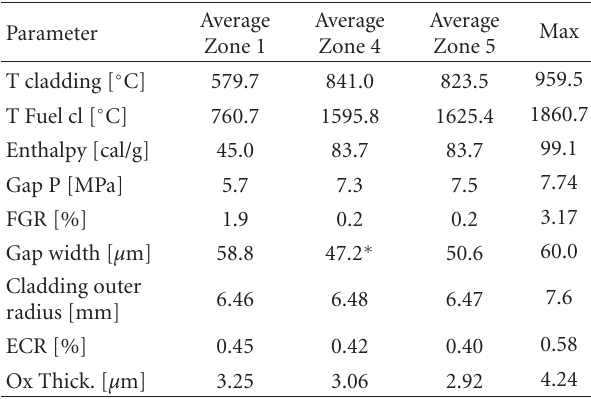
Table 3: Main outcomes from the analysis: zones 1, 4, and 5.